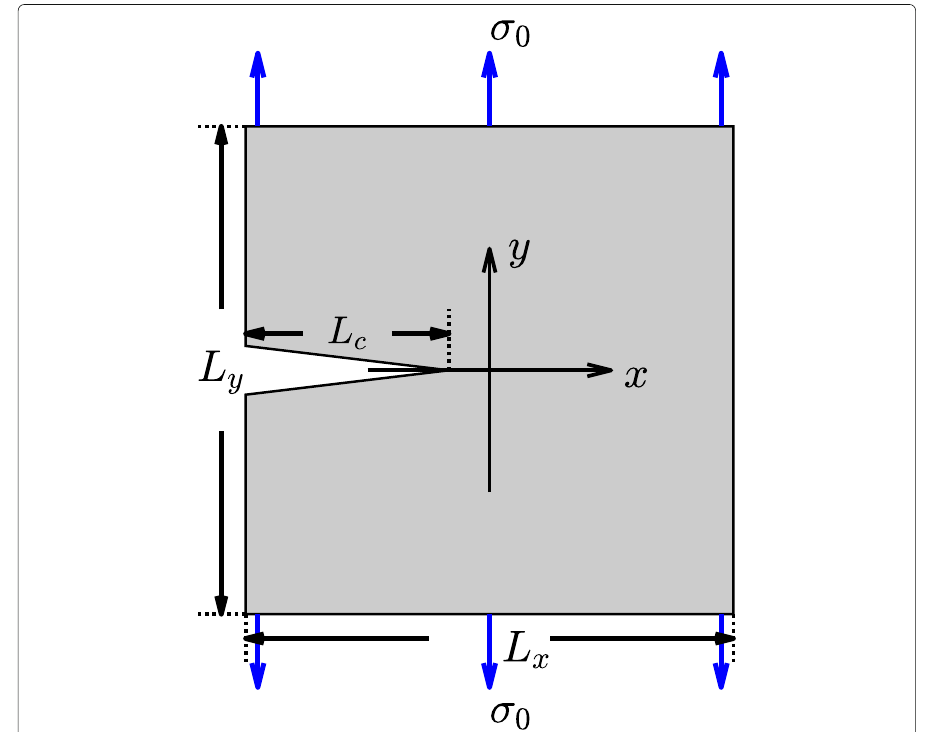
Fig. 10 Schematic diagram of a rectangular plate with a mode-I central